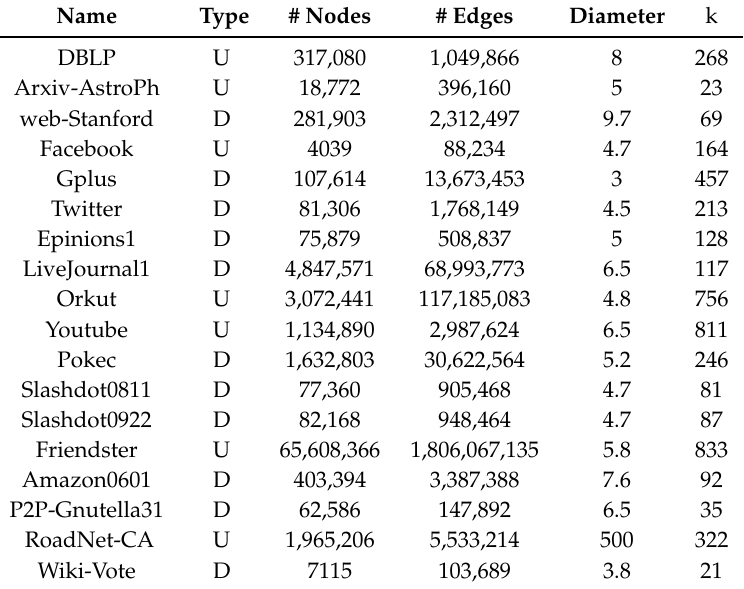
Table 2. Complex network datasets and values of their